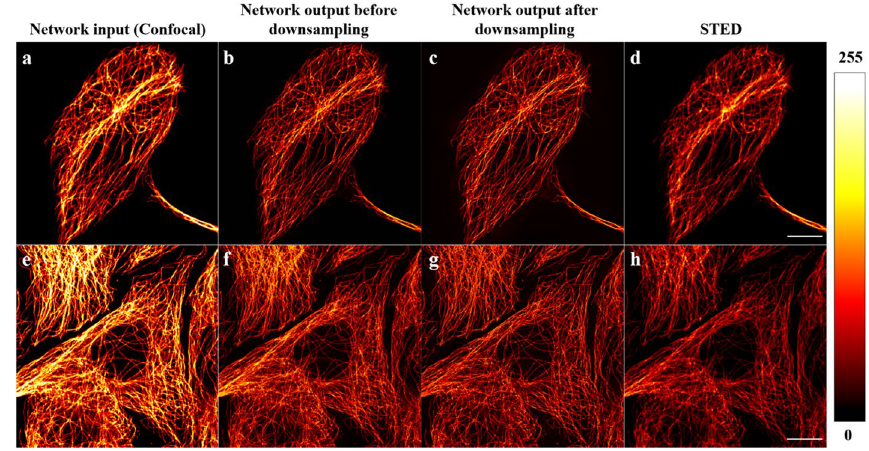
Fig. 6 Super-resolution imaging of large FOV of confocal images acquired on a Leica TCS SP8 STED confocal microscope using TCAN. ( a , e ) Diffraction-limited confocal microscopy images of the microtubules are used as input to the network. ( b , f ) The super-resolved network inference images before downsampling the input images to match the pixel size of the training data. ( c , g ) The super-resolved network inference images after downsampling the input images to match the pixel sizes of the training data. ( d , h ) The STED images of the same field of view. Scale bar in ( d ) is 8 μm, and scale bar in ( h ) is 10